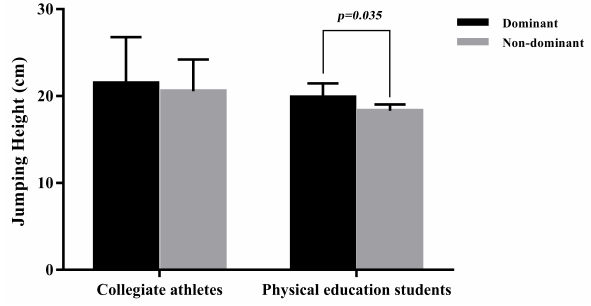
Fig. 5. Comparison of lower limb jumping height of dominant and non-dominant leg at H-SLDJ.